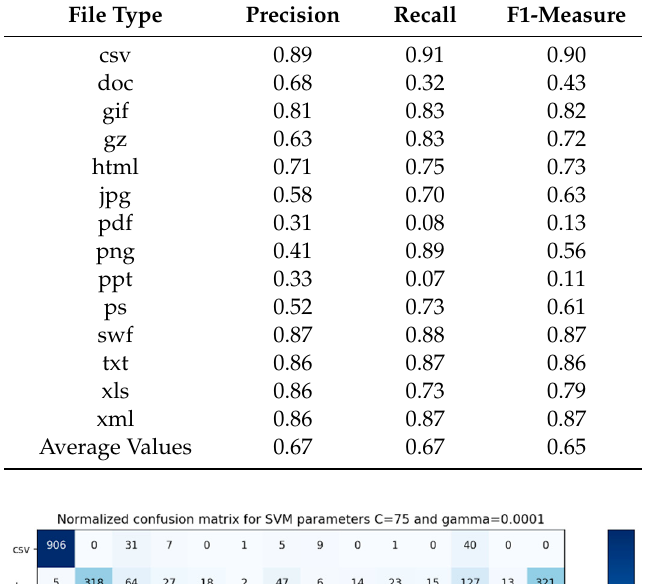
Table 4. Classifier results for hierarchy 1.